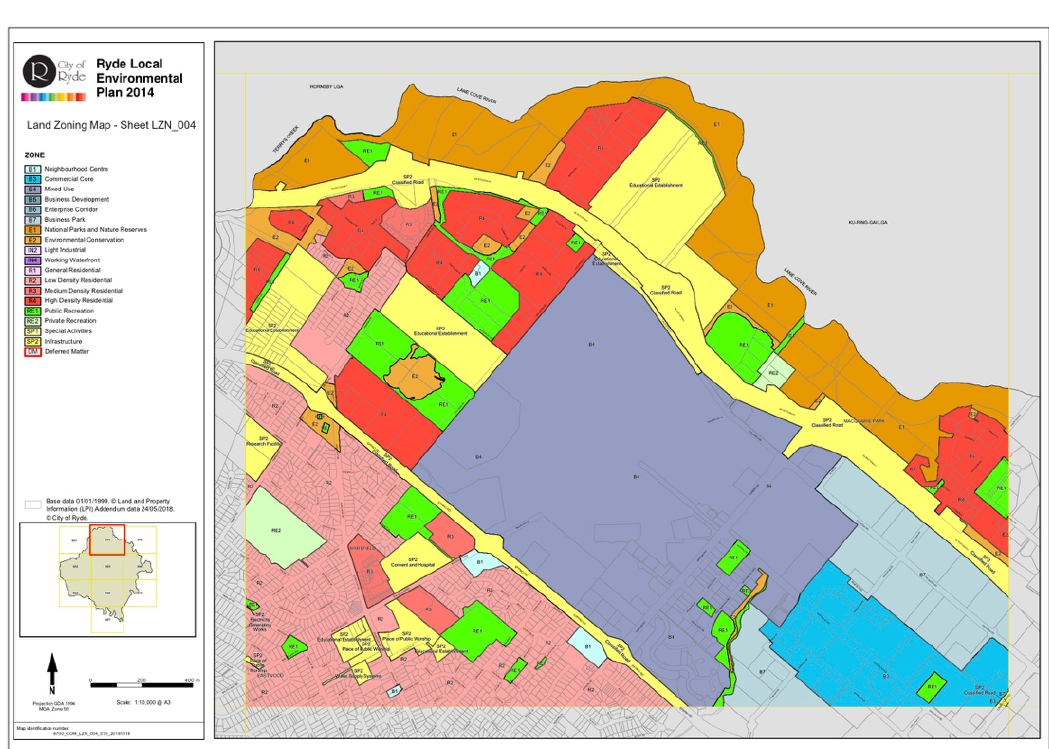
Figure A5. Macquarie Park Height of Building LEP.